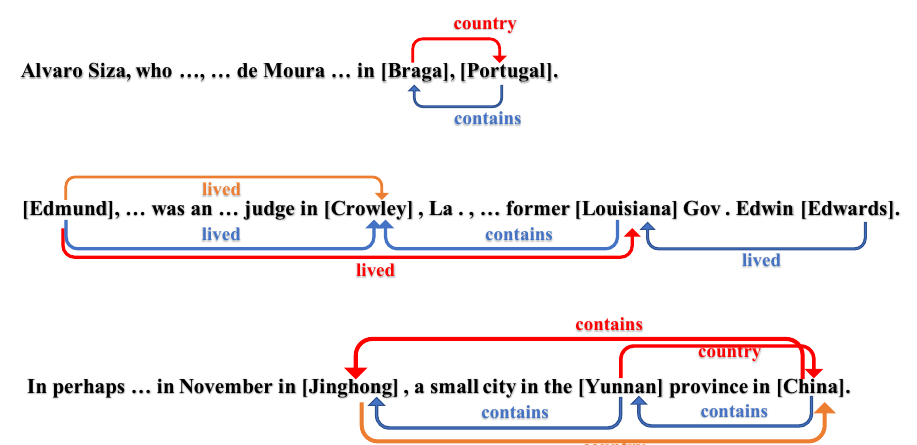
Figure 6. Three examples with implicit triples. Entities are in square brackets. Blue arrows indicate relational connections predicted by TPLinker, as well as ours. The orange arrows indicate that relational connections do not appear in golden triples. The red arrows indicate implicit connections only inferred by